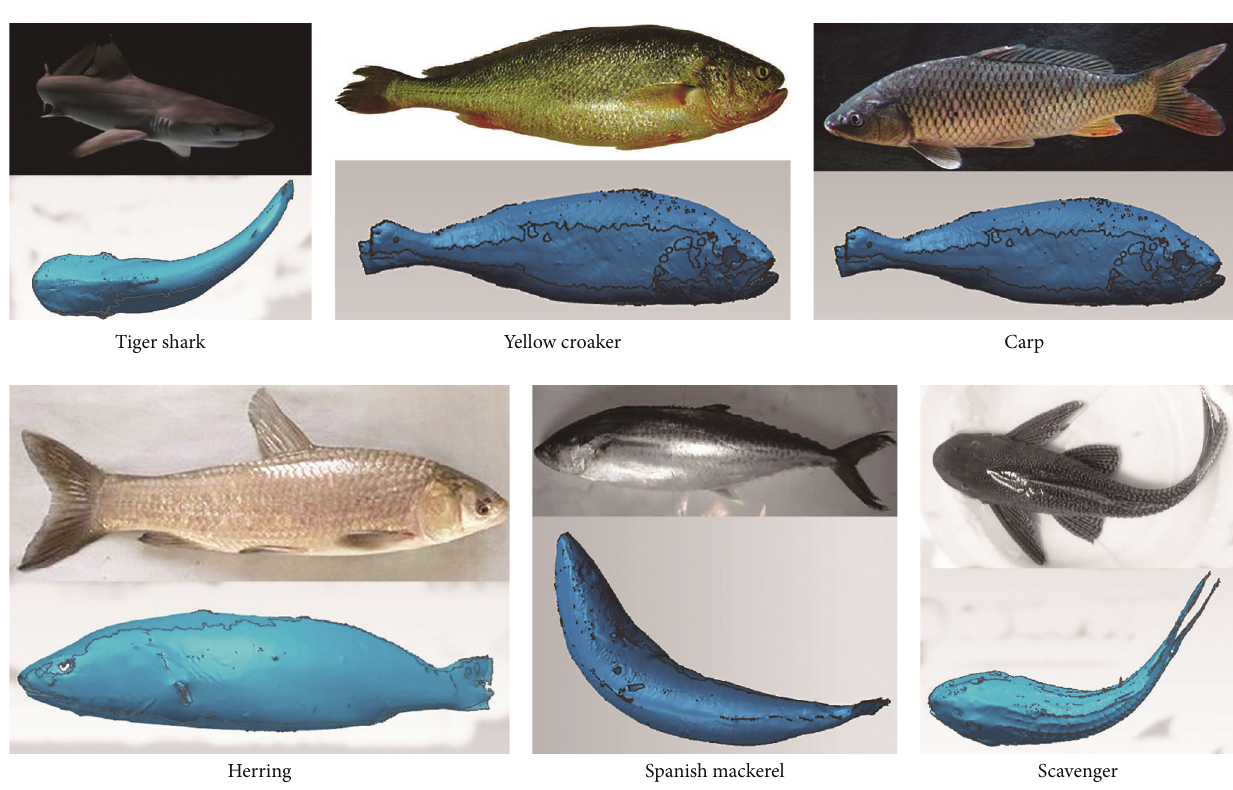
Figure 3: Scanning data of fish and fish